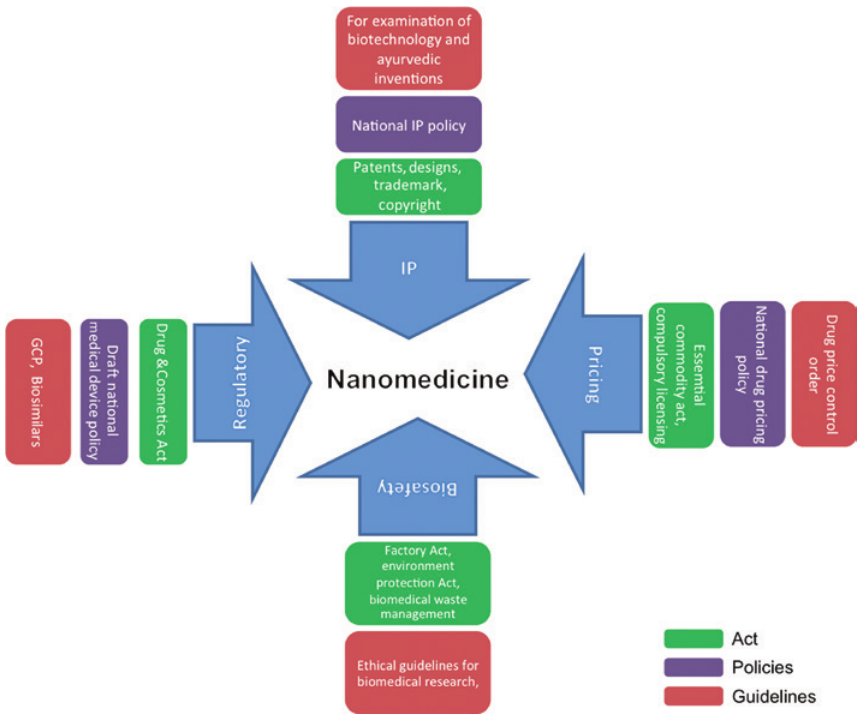
Figure 7: An overview of relevant acts, policies, and guidelines applicable to nanomedicine (source: compiled by